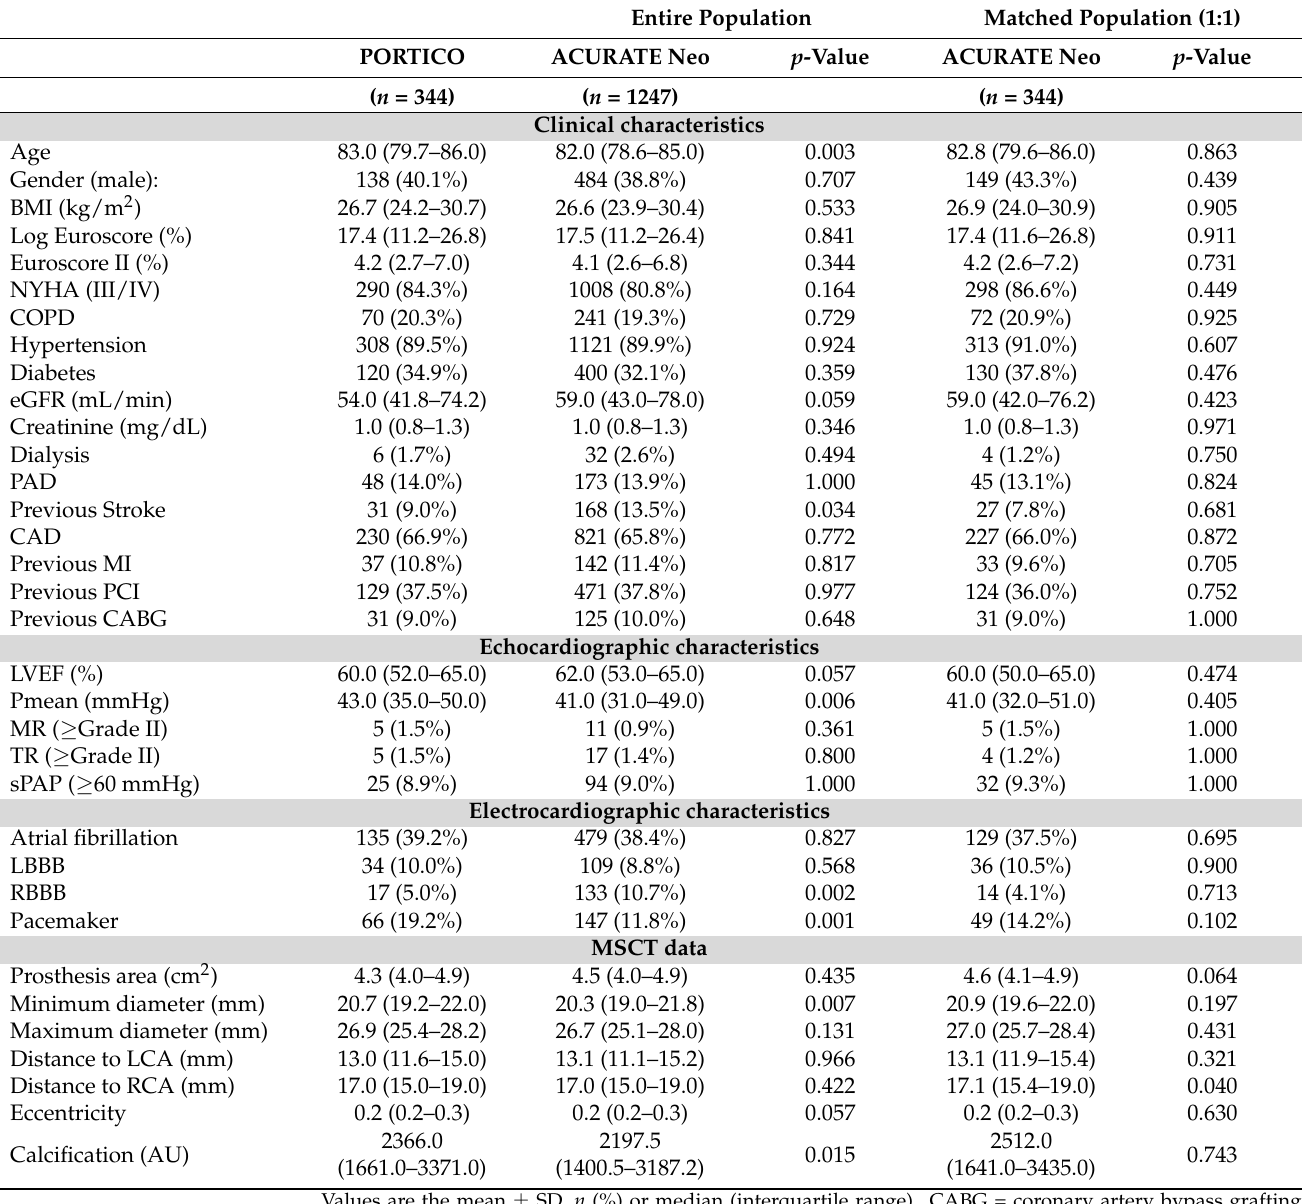
Table 1. Baseline characteristics of the patients treated with ACURATE neo and of the entire popula- tion and the matched population treated with